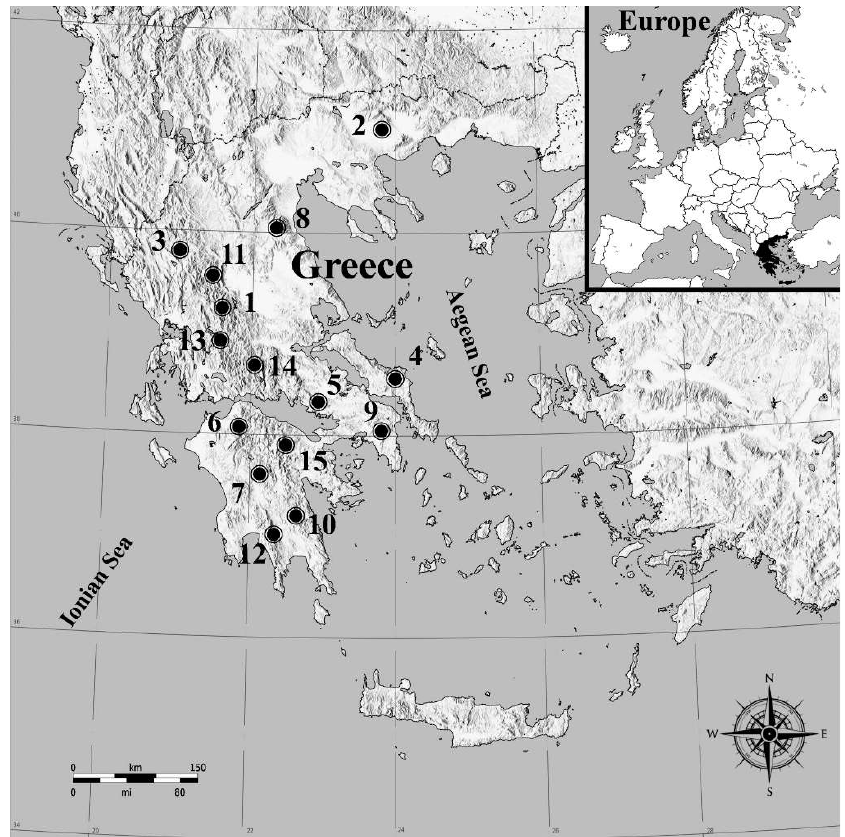
Figure 1. Map of Greece with the sampled mountains: Agrafa—1, Ano Vrontous—2, Athamanika— 3, Dirfis—4, Helicon—5, Helmos—6, Menalon—7, Olympus—8, Parnis—9, Parnon—10, Pindos (central)—11, Taygetus—12, Tymfristos—13, Vardousia—14 and Ziria (Killini)—15.